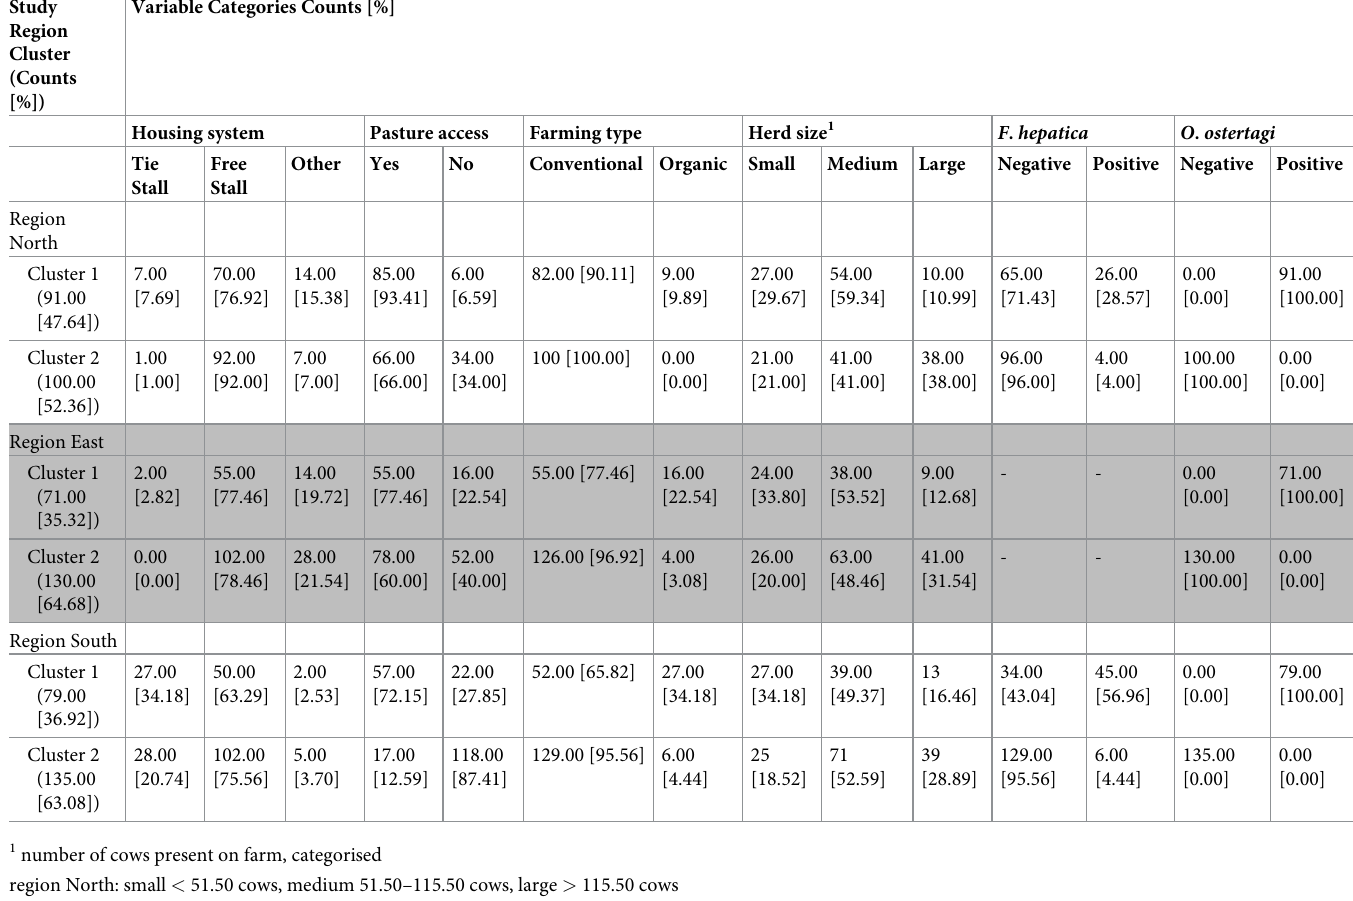
Table 5. Descriptive statistics (observations per cluster) of the O . ostertagi cluster analysis across study regions (categorical